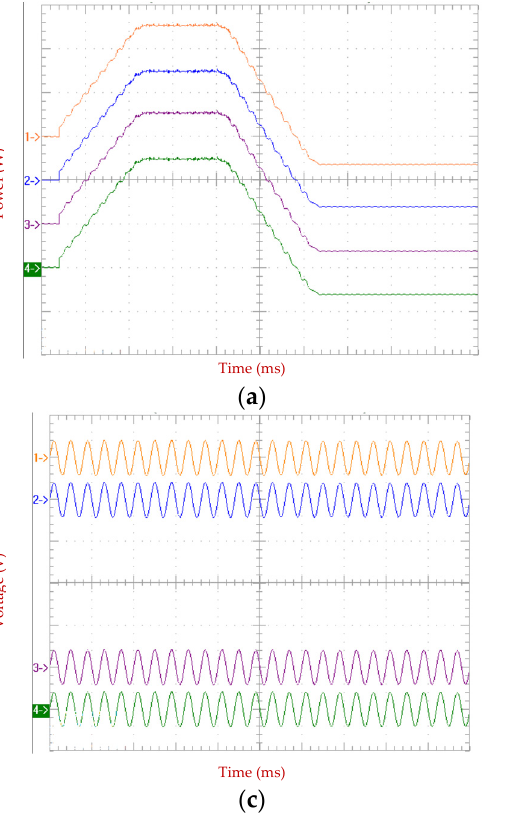
Figure 22. Experimental results of the MIs for battery/grid discharging and charging. ( a ) Powers: top (Ch1 and Ch2), MI 1 and MI 2 ; bottom (Ch3 and Ch4), MI 3 and MI 4 ; 50 ms/div–100 W/div. ( b ) Top (Ch1), grid voltage at PCC; bottom (Ch2), grid current; 50 ms/div–200 V/div–5 A/div. ( c ) Output voltages: top (Ch1 and Ch2), MI 1 and MI 2 ; bottom (Ch3 and Ch4), MI 3 and MI 4 ; 50 ms/div–200 V/div. ( d ) Input (power supplies) voltages: top (Ch1 and Ch2), MI 1 and MI 2 ; bottom (Ch3 and Ch4), MI 3 and MI 4 ; 50 ms/div–20 V/div.